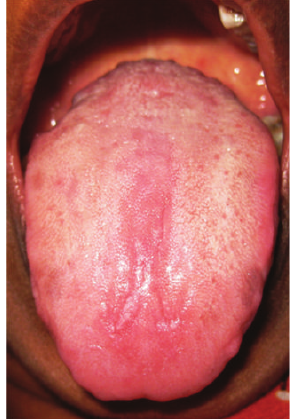
Figure 3: Lateral longitudinal type.